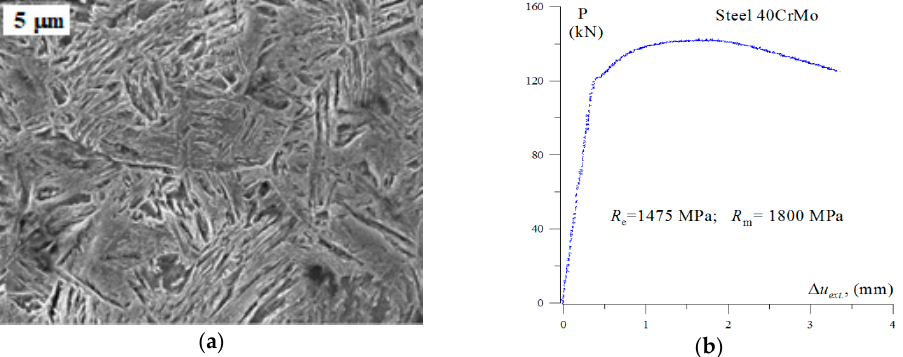
Figure 2. ( a ) Microstructure of tempered martensite of 40CrMo steel; and ( b ) loading plot of a cylindrical specimen in uniaxial tensile